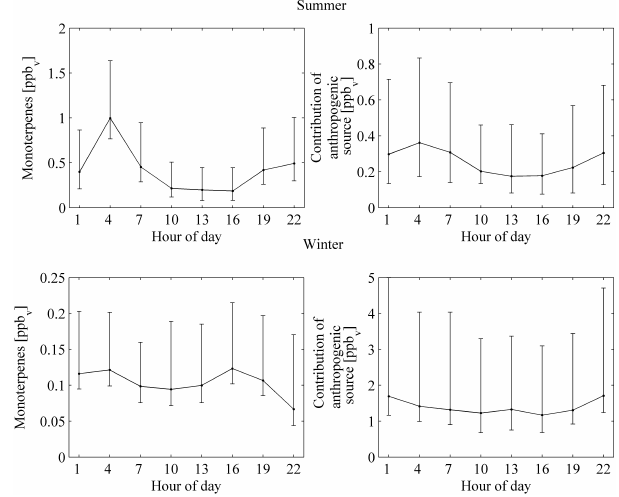
Figure 9. Diurnal cycles of monoterpenes (left) and the diurnal cy- cle of the anthropogenic source’s contribution (right) in summer (top row) and in winter (bottom row) are presented as mean values and 20 to 80 percentiles. Data in all figures are from the urbanized continental